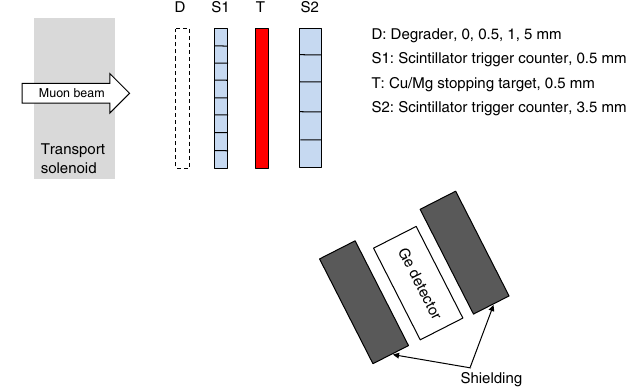
FIG. 2. Schematic of the independent detection systems for measuring the muon flux. After a 36° arc of the muon beam line, the beam, including muons, exits the transport solenoid and optionally passes through an aluminum degrader D. The beam then passes through a plastic scintillator trigger counter S1 and a target T, where muons are stopped. X rays emitted by a captured muon dropping down orbital energy levels are detected in a germanium detector, which is also shielded. Electrons arising from the decay of a muon are registered in another plastic scintillator,